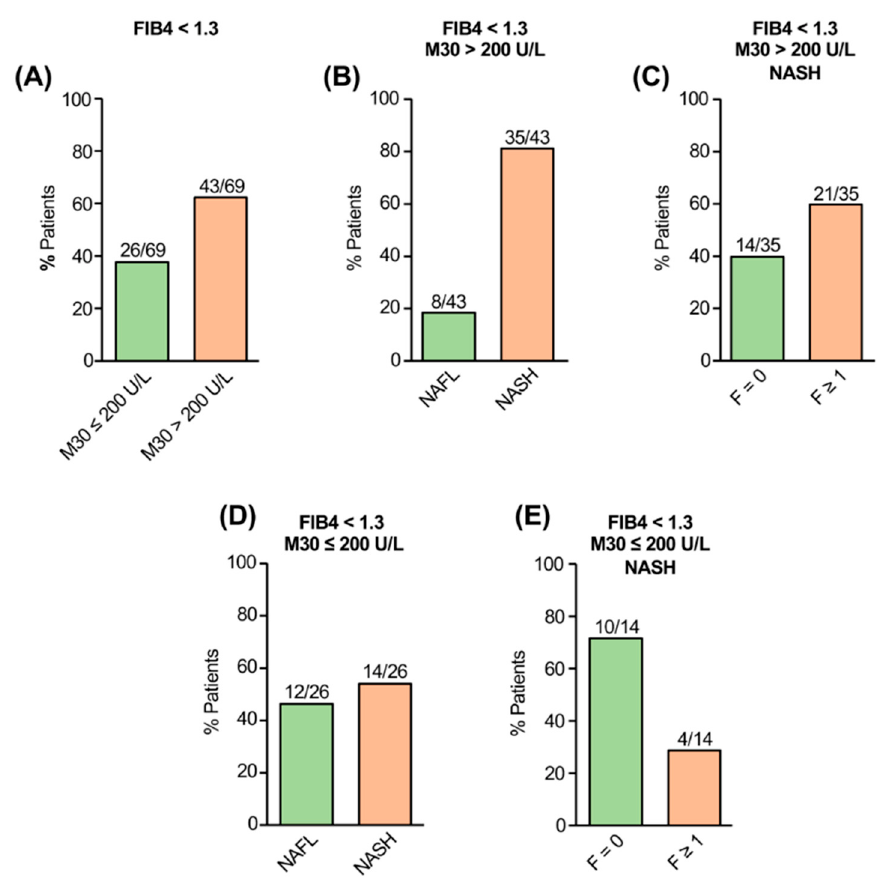
Figure 1. Serological detection of caspase-cleaved K18 by the M30 ELISA in NAFLD patients with low FIB-4 (exploration cohort). Most patients with FIB-4 < 1.3 showed elevated (>200 U/L) M30 levels ( A ). Most patients with FIB-4 < 1.3 and elevated M30 levels revealed NASH ( B ). Patients with NASH and elevated M30 levels despite low FIB-4 revealed liver fibrosis in the majority of cases ( C ). Vice versa, NAFLD patients with FIB-4 < 1.3 and non-elevated M30 ( ≤ 200 U/L) showed NAFL or NASH without fibrosis in the majority of cases ( D , E ).